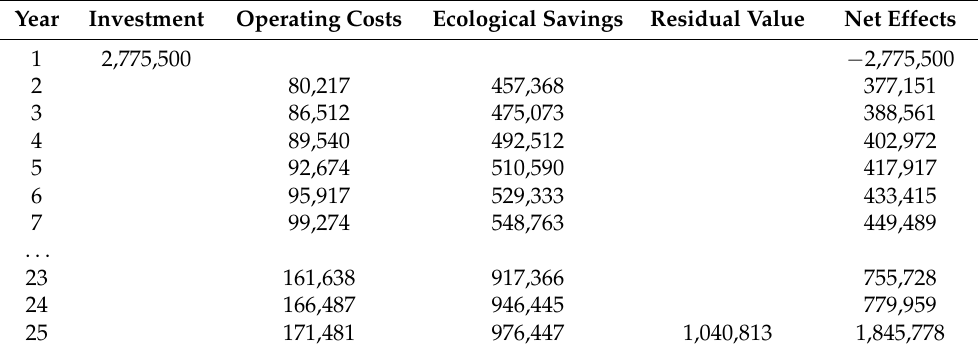
Table 5. Economic flow projection of the WWTP